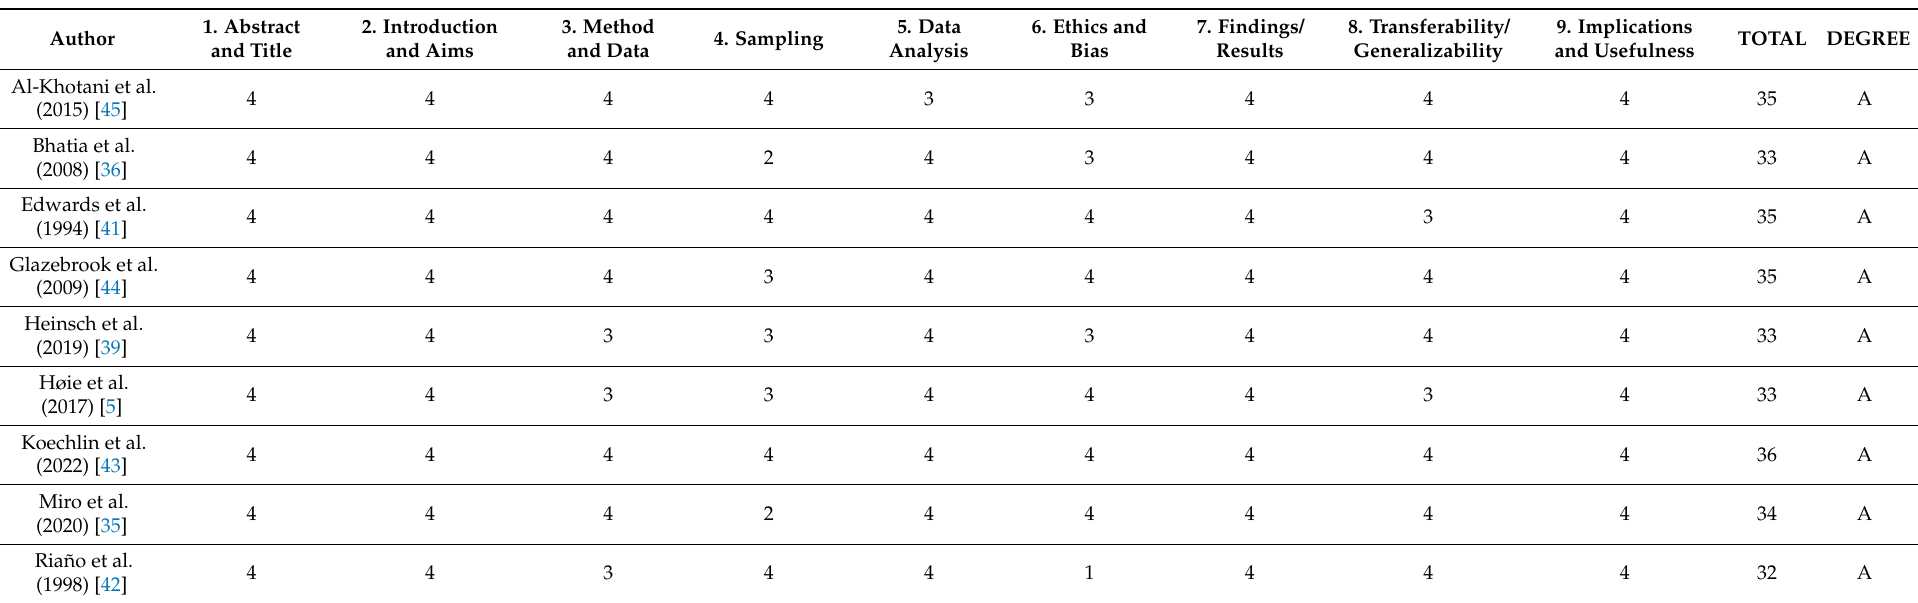
Table 2. Risk of bias of the clinical studies included in the systematic